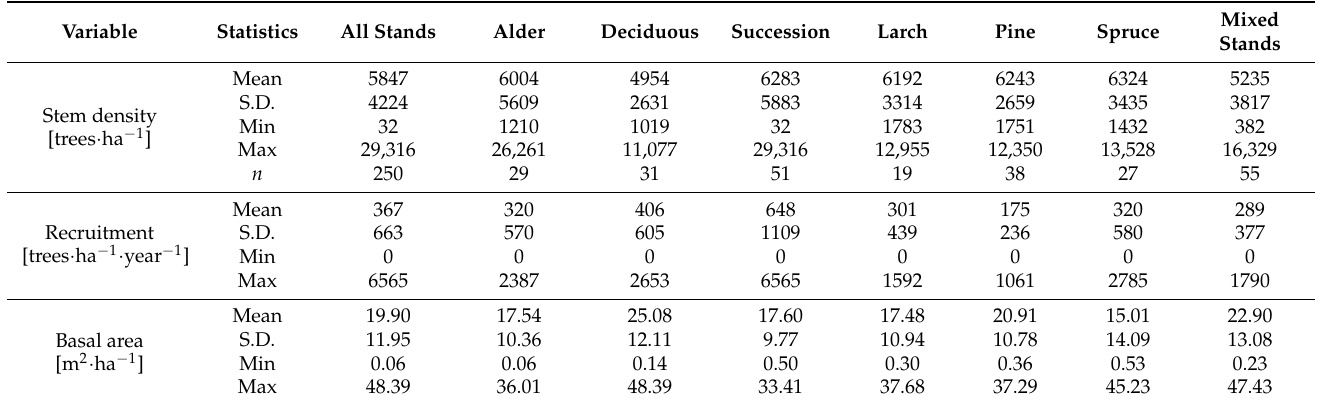
Table A4. Descriptive statistics of stand characteristics for inventory plot data.